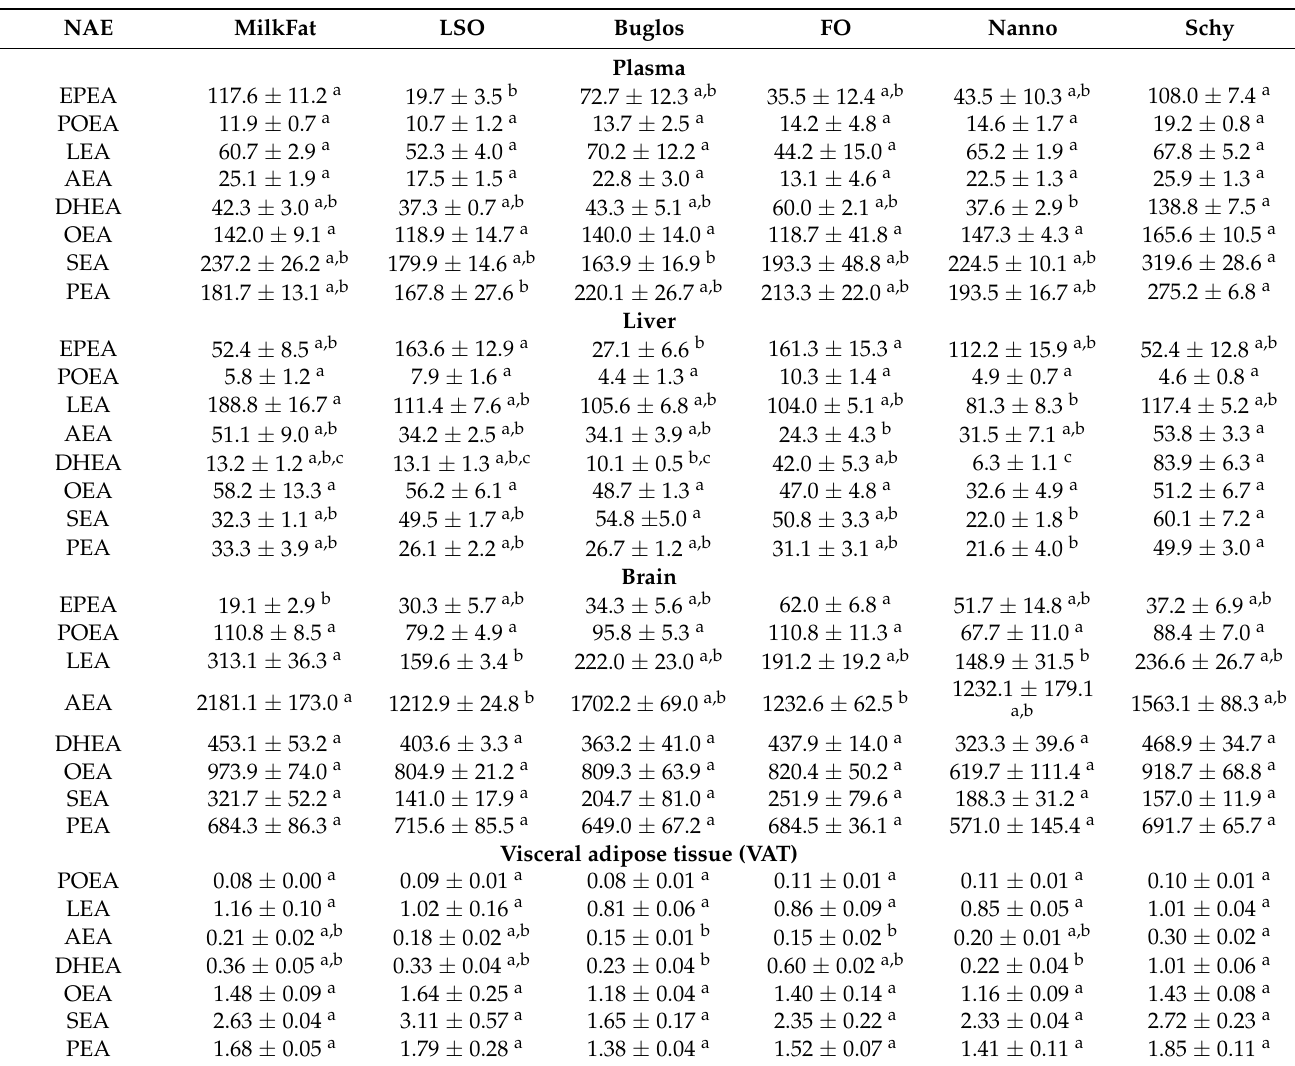
Table 6. Changes of N-acylethanolamines (NAE) profile in key metabolic tissues of Wistar rats fed with different